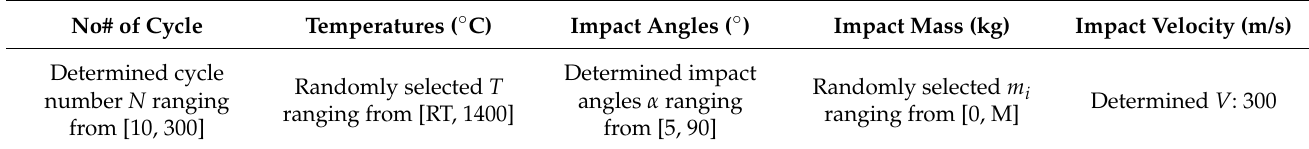
Table 8. Parameters used to calculate erosion rates at different impact